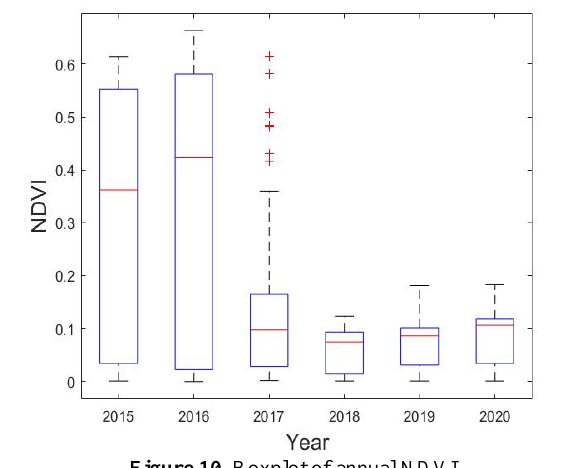
Figure 10. Boxplot of annual NDVI.